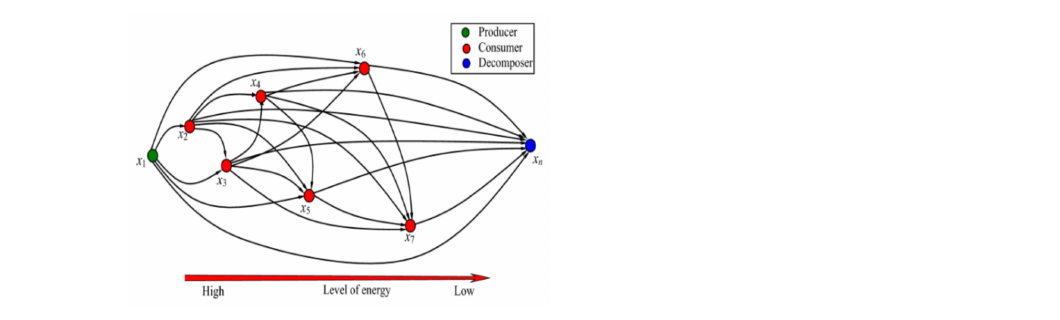
Figure 6. AEO ecosystem. Algorithm 1: Pseudocode of Artificial Ecosystem-based Optimization for optimal the sizing of